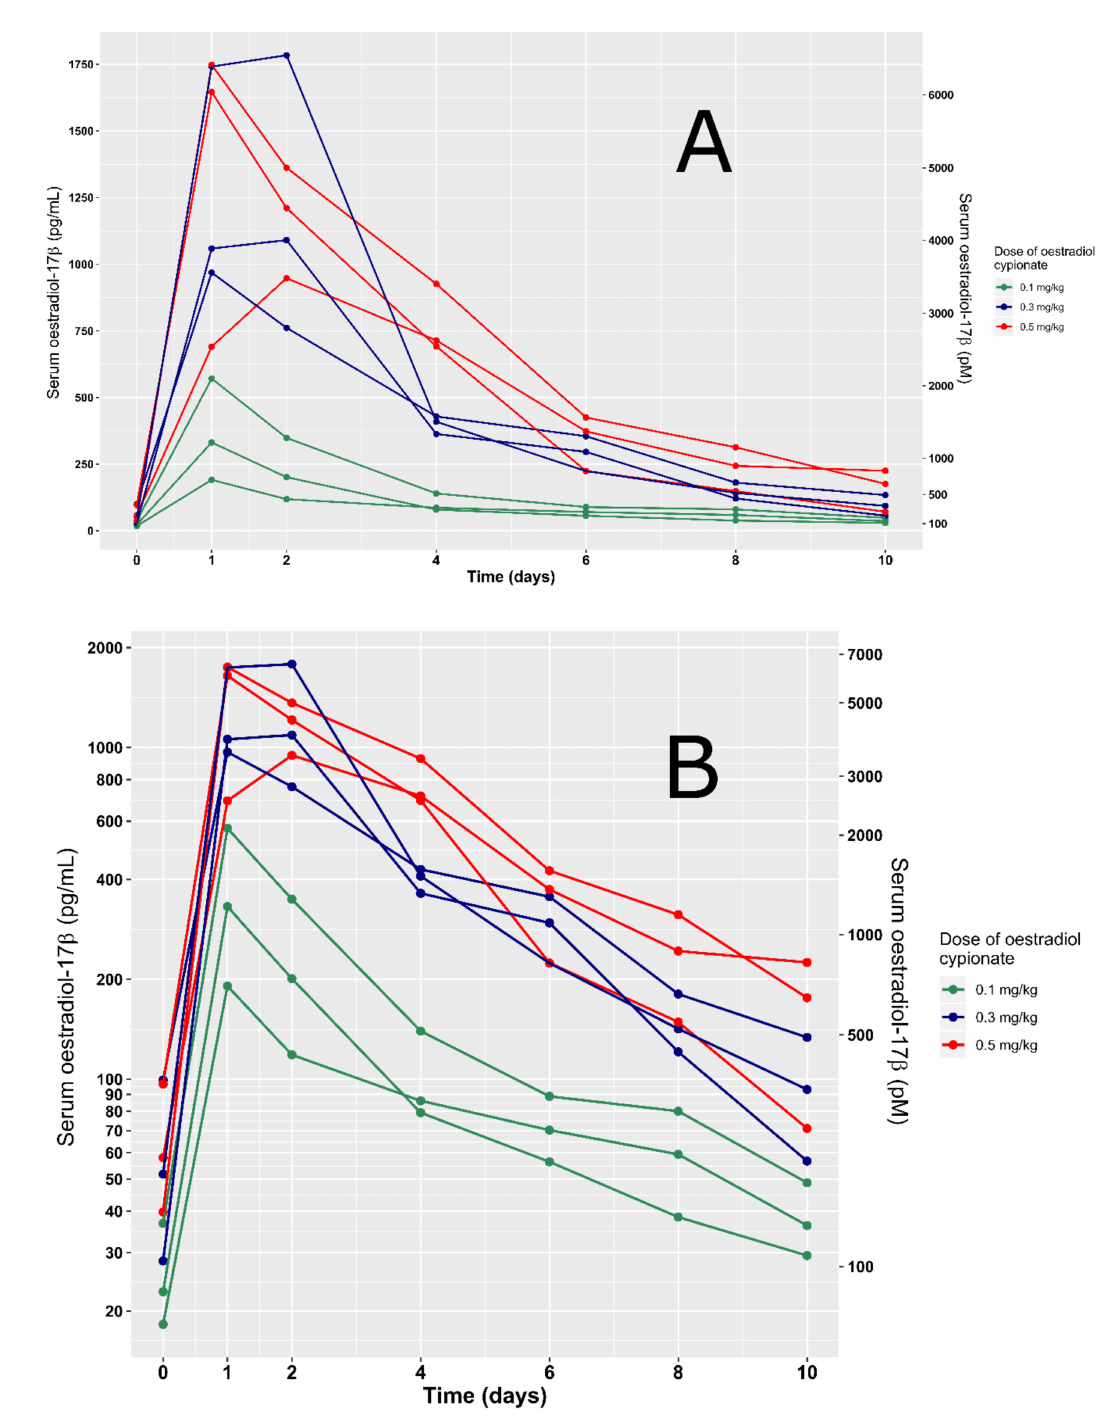
Figure 1. Observed serum concentration of estradiol-17 β following the intramuscular administration of 0.1–0.52 mg / kg of estradiol cypionate to nine feral cats. Linear ( A ) and log10 scales ( B